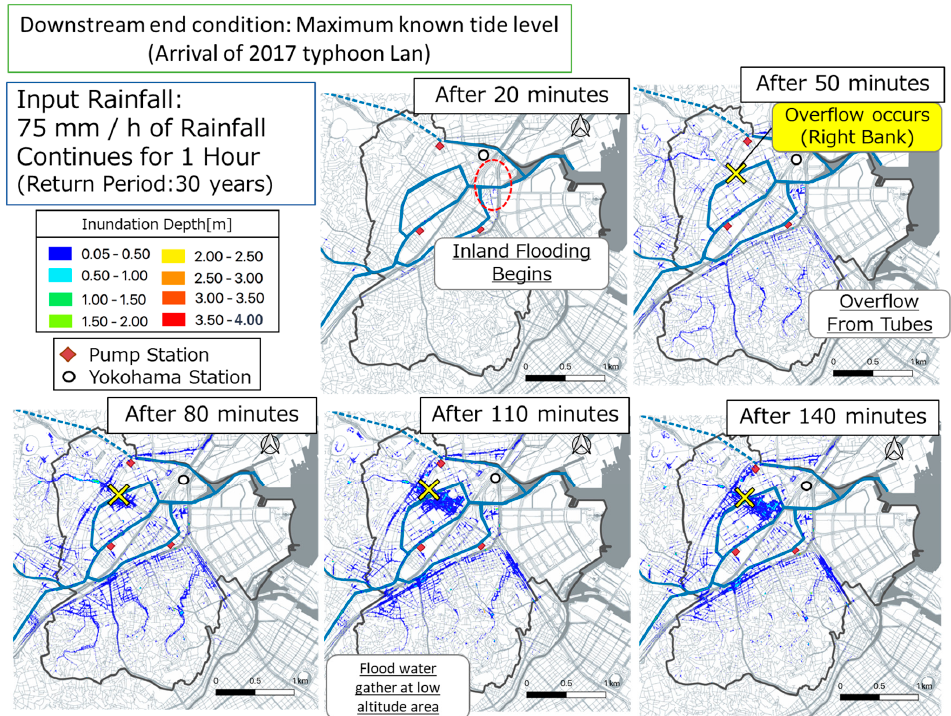
Figure 14. Inundation process obtained through the constructed river water and inland flooding Figure14. analysis. Table 3. Verification results.